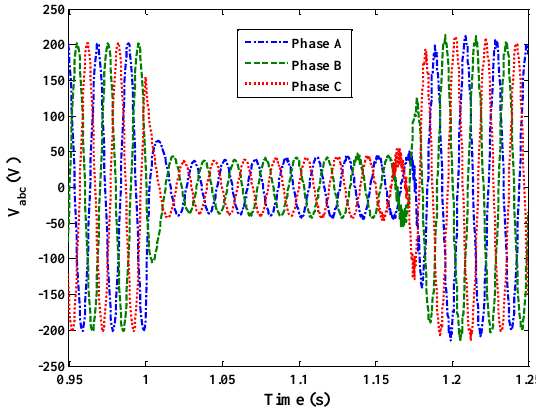
Figure 8. Three-phase voltages of the PV generation system under the symmetrical fault.